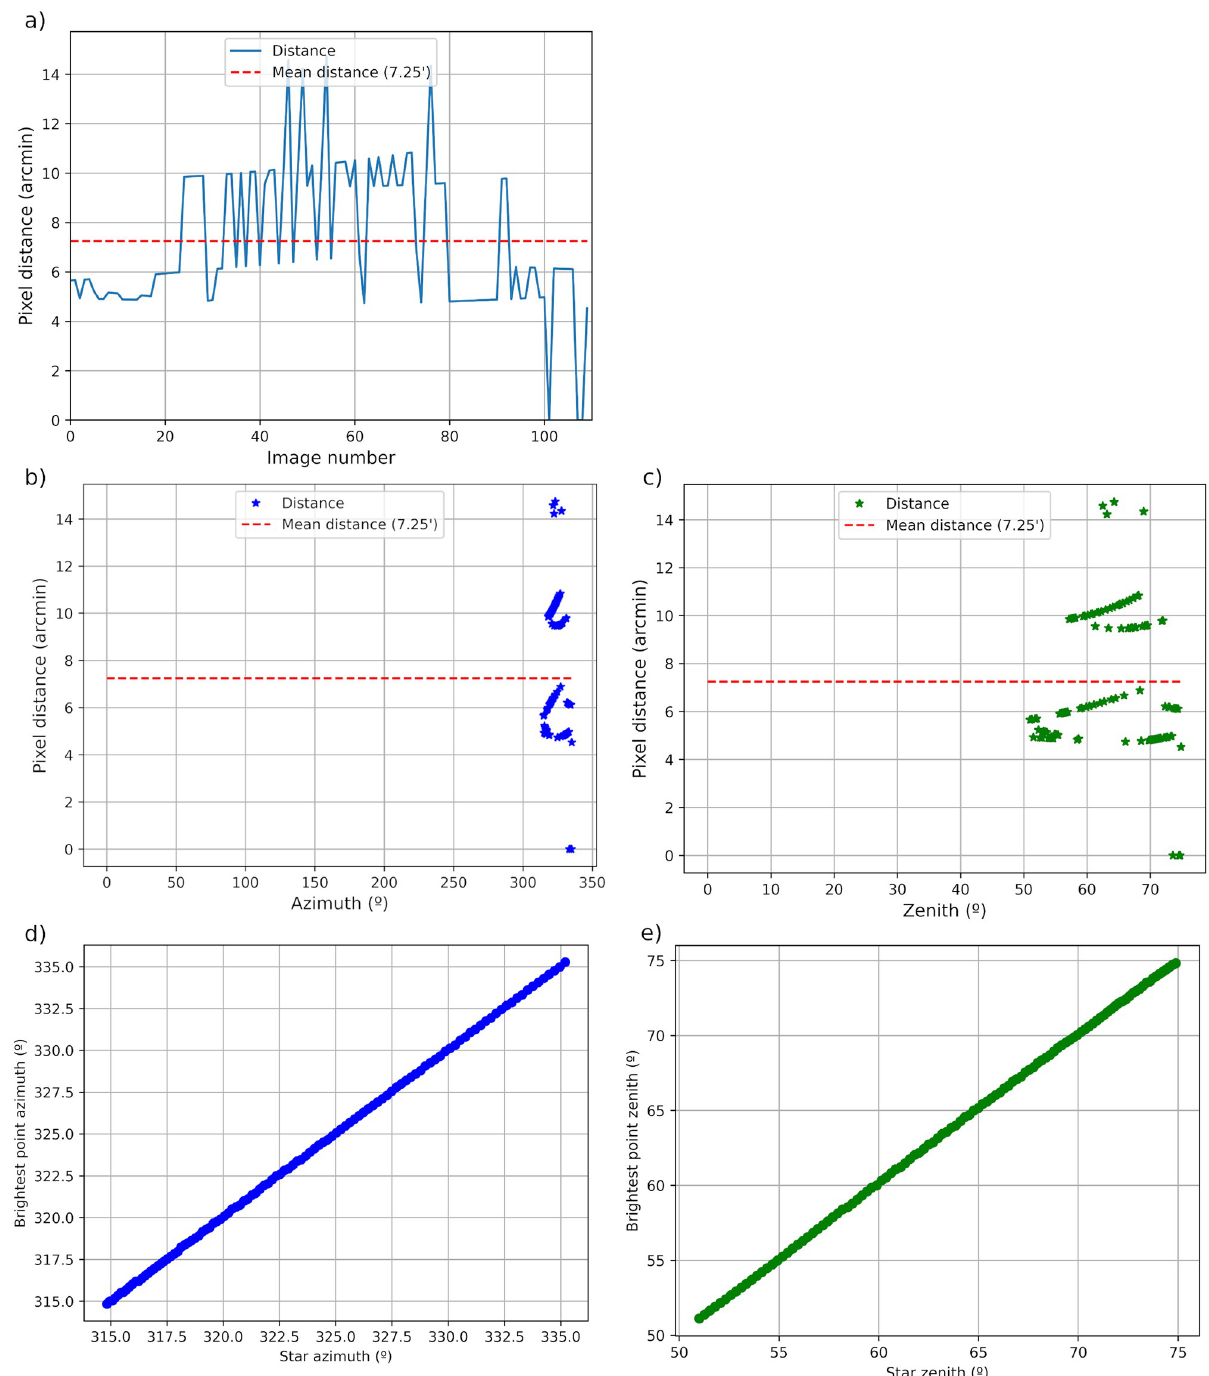
Fig 8. Performance of the obtained calibrations matrices for Alioth star positions: a) azimuth obtained with the calibration for the located star position (brightest point) as a function of the real star azimuth; b) zenith obtained with the calibration for the located star position (brightest point) as a function of the real star zenith; c) absolute pixel distance between the star position given by the calibration matrices and the position of the assumed real center of the star in the image (brightest point in a square box defined by the height or width of the sky image) as a function of star azimuth angle (red dotted line represents the mean absolute distance); d) absolute pixel distance between the star position given by the calibration matrices and the position of the assumed real center of the star in the image (brightest point in a square box defined by the height or width of the sky image) as a function of star zenith angle (red dotted line represents the mean absolute distance); e) absolute pixel distance between the star position given by the calibration matrices and the position of the assumed real center of the star in the image (brightest point in a square box defined by the height or width of the sky image) for each available image (red dotted line represents the mean absolute